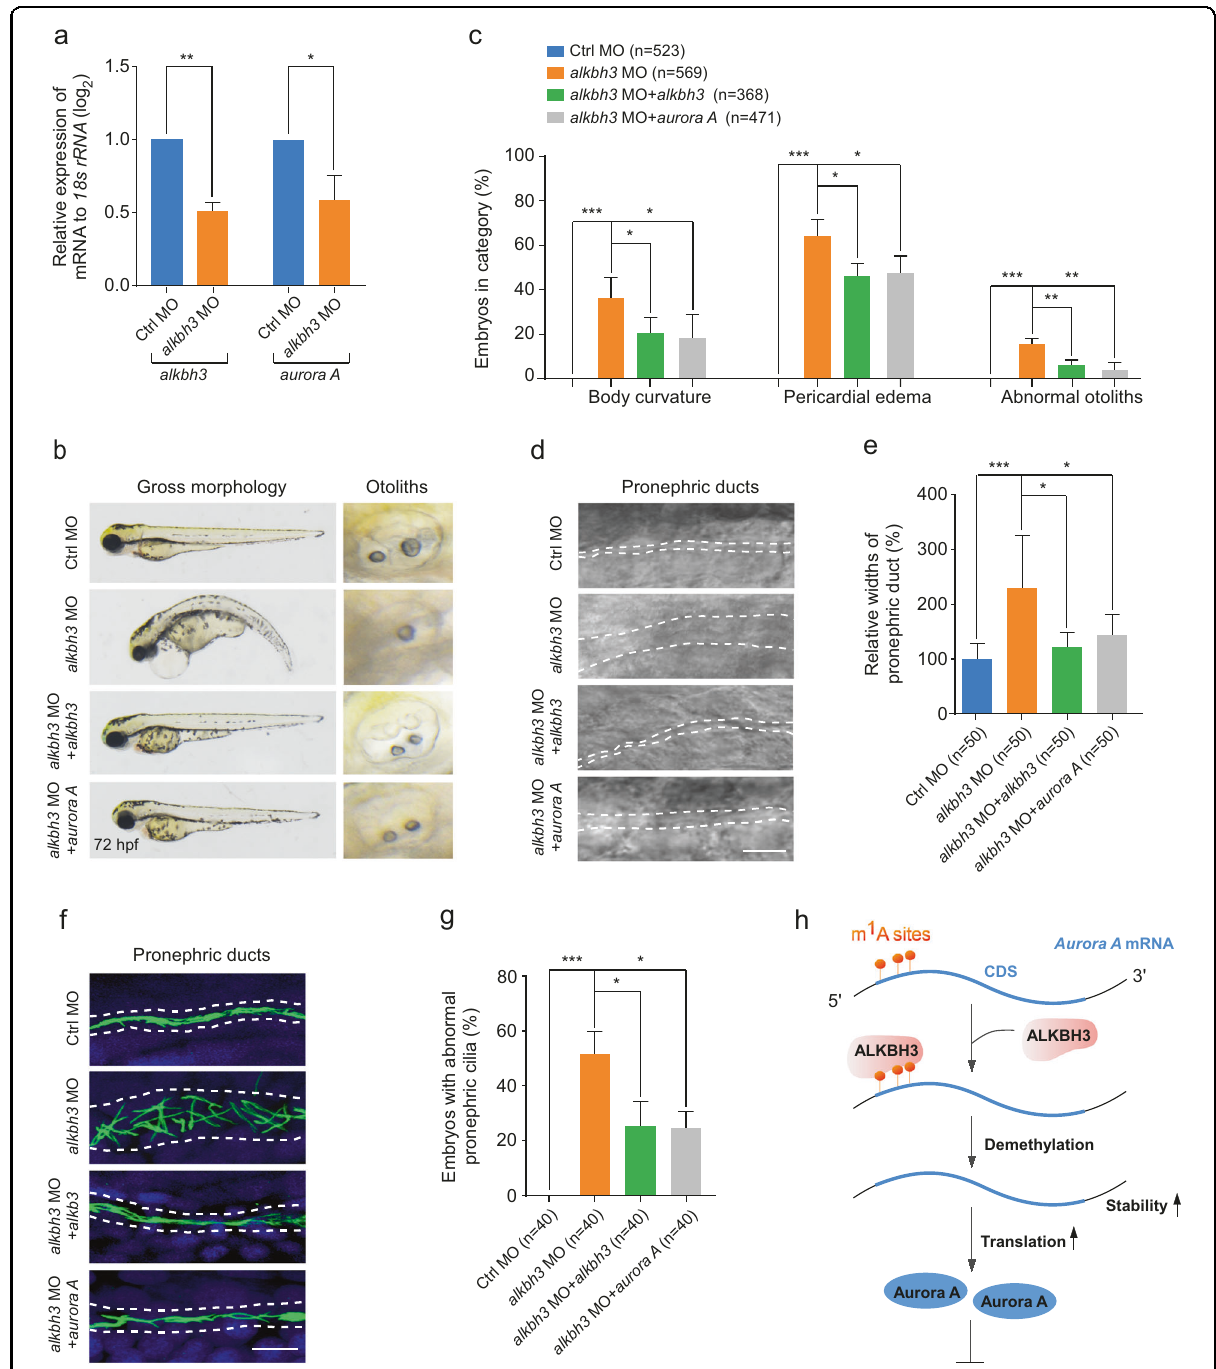
Fig. 7 Ectopic expression of Aurora A rescues the ciliary defects in alkbh3 morphants. Zebra fi sh embryos were injected with the indicated MOs or mRNAs at 1-cell stage and subjected to the following assays. a Quantitative RT-PCR of aurora A mRNA levels in alkbh3 morphants at 48 hpf. b , c Representative images and quanti fi cation of gross morphology of embryos injected with the indicated MOs or mRNAs. d , e Bright fi eld images and statistical analyses of zebra fi sh pronephric ducts. The lumen of pronephric ducts is indicated by white dashed lines. The median width of control morphants ’ ducts was set at 100%. f Immuno fl uorescence of cilia in pronephric ducts. Cilia were stained by anti-acetylated- α -tubulin antibody (green). The lumen of pronephric ducts is indicated by white dashed lines. Scale bar, 10 μ m. g The percentage of embryos with abnormal pronephric cilia. Data are presented as the means ± SD from at least three independent experiments. Student ’ s t- test; * P < 0.05, ** P < 0.01, *** P < 0.001. h Working model of ALKBH3-dependent m 1 A demethylation of Aurora A mRNA to inhibit ciliogenesis. See text for